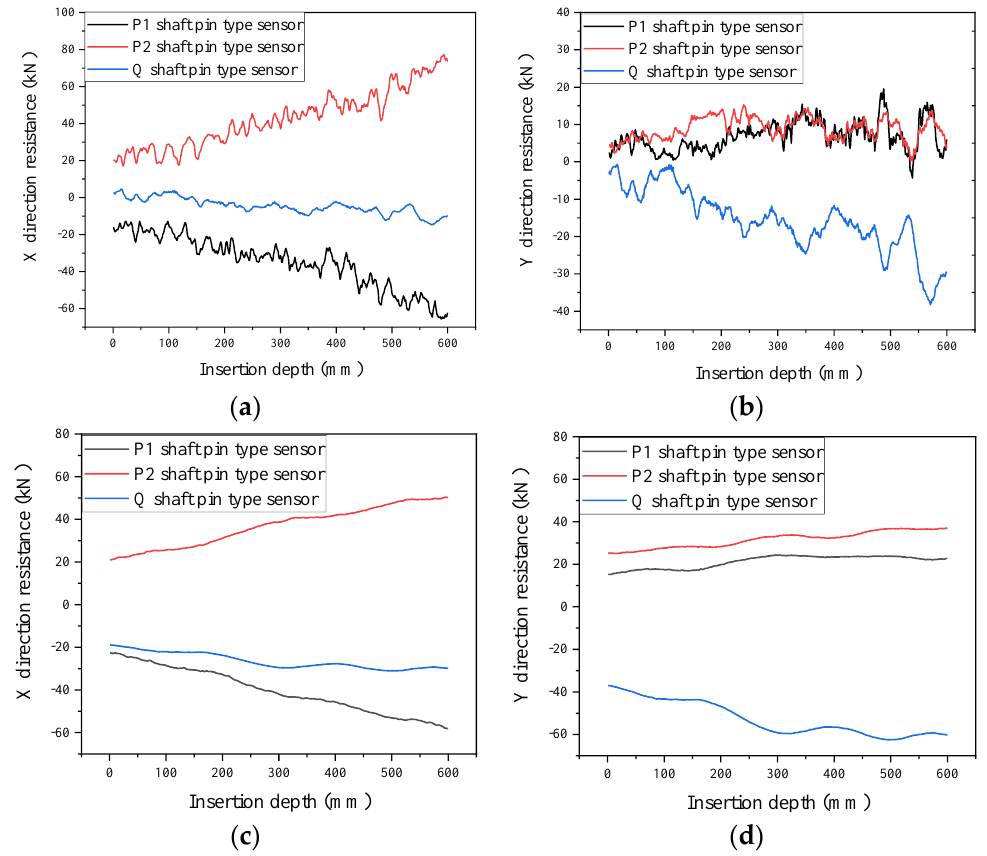
Figure 6. Resistance by shaft-pin-type sensor. ( a ) X direction resistance of gravel sample; ( b ) Y direction resistance of gravel sample; ( c ) X direction resistance of sand sample; ( d ) Y direction resistance of the sand sample.